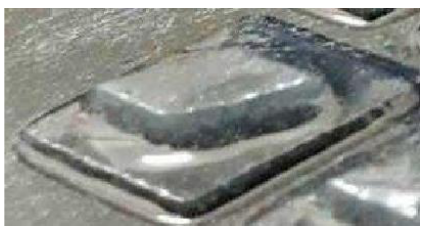
Figure 4. Side view of developed structure during investigation of curing times.